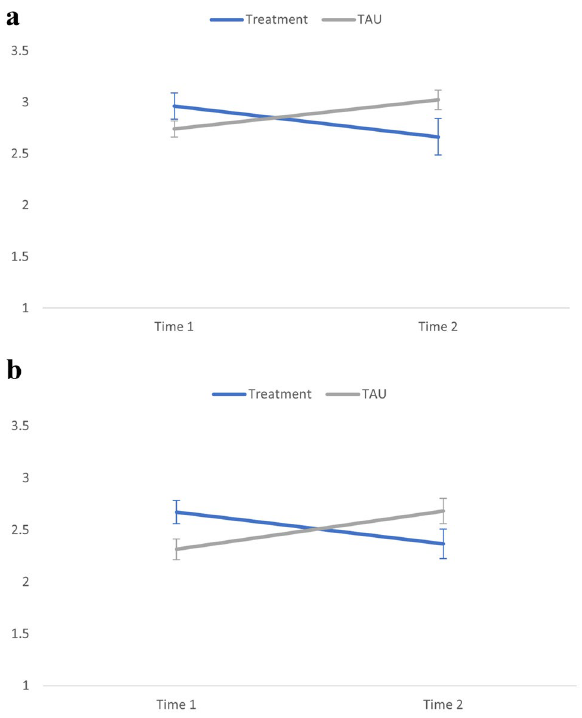
Figure 1. ( a ) Estimated means for child intra-topic latency. Error bars depict ± 2 standard errors. ( b ) Estimated means for examiner intra-topic latency. Error bars depict ± 2 standard